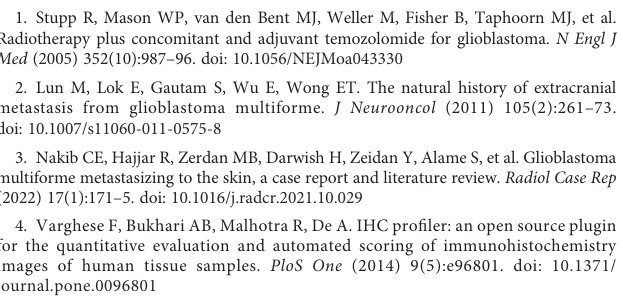
SUPPLEMENTARY FIGURE 1 The serial perioperative imaging and histopathological characteristics at fi rst surgery. (A) Pre-operativeaxialcomputertomographyscanimagesshowingthe temporal tumor. (B) The postoperative magnetic resonance imaging (3 days after surgery). (C) Hematoxylin and eosin stains of the original tumor show tumor with necrosis and glomerular vascular proliferation. Scale bar = 100 m m. SUPPLEMENTARY FIGURE 2 The timeline of therapy and disease status of the